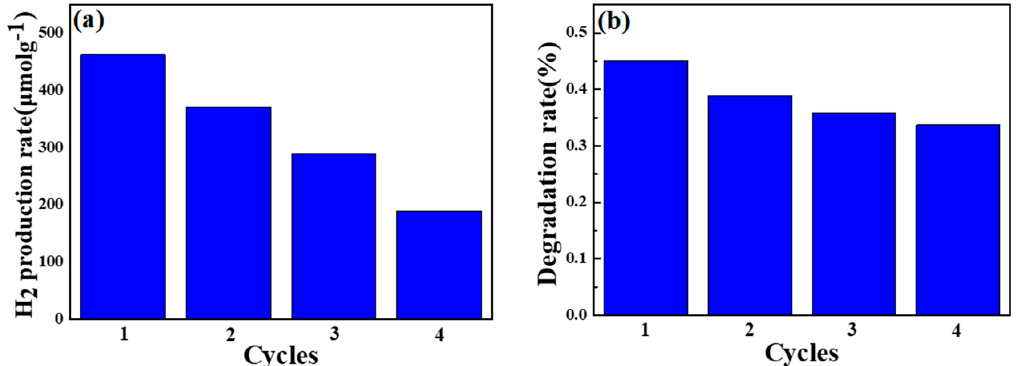
Figure 10. Recycling tests of the PC004 photocatalyst for ( a ) hydrogen production and ( b ) MO degradation under visible light irradiation.